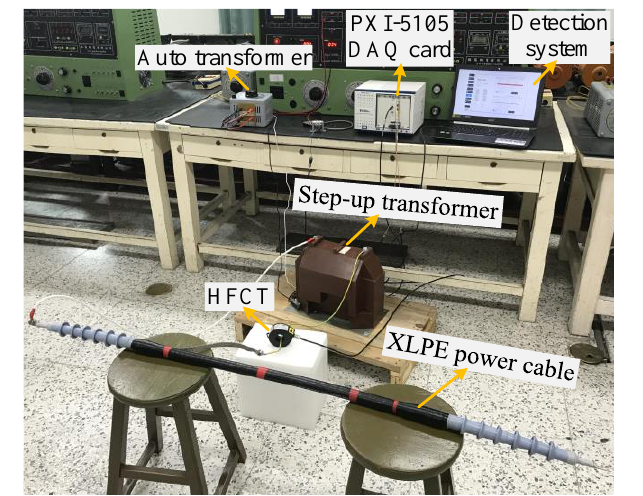
Figure 3. Power cable test process.